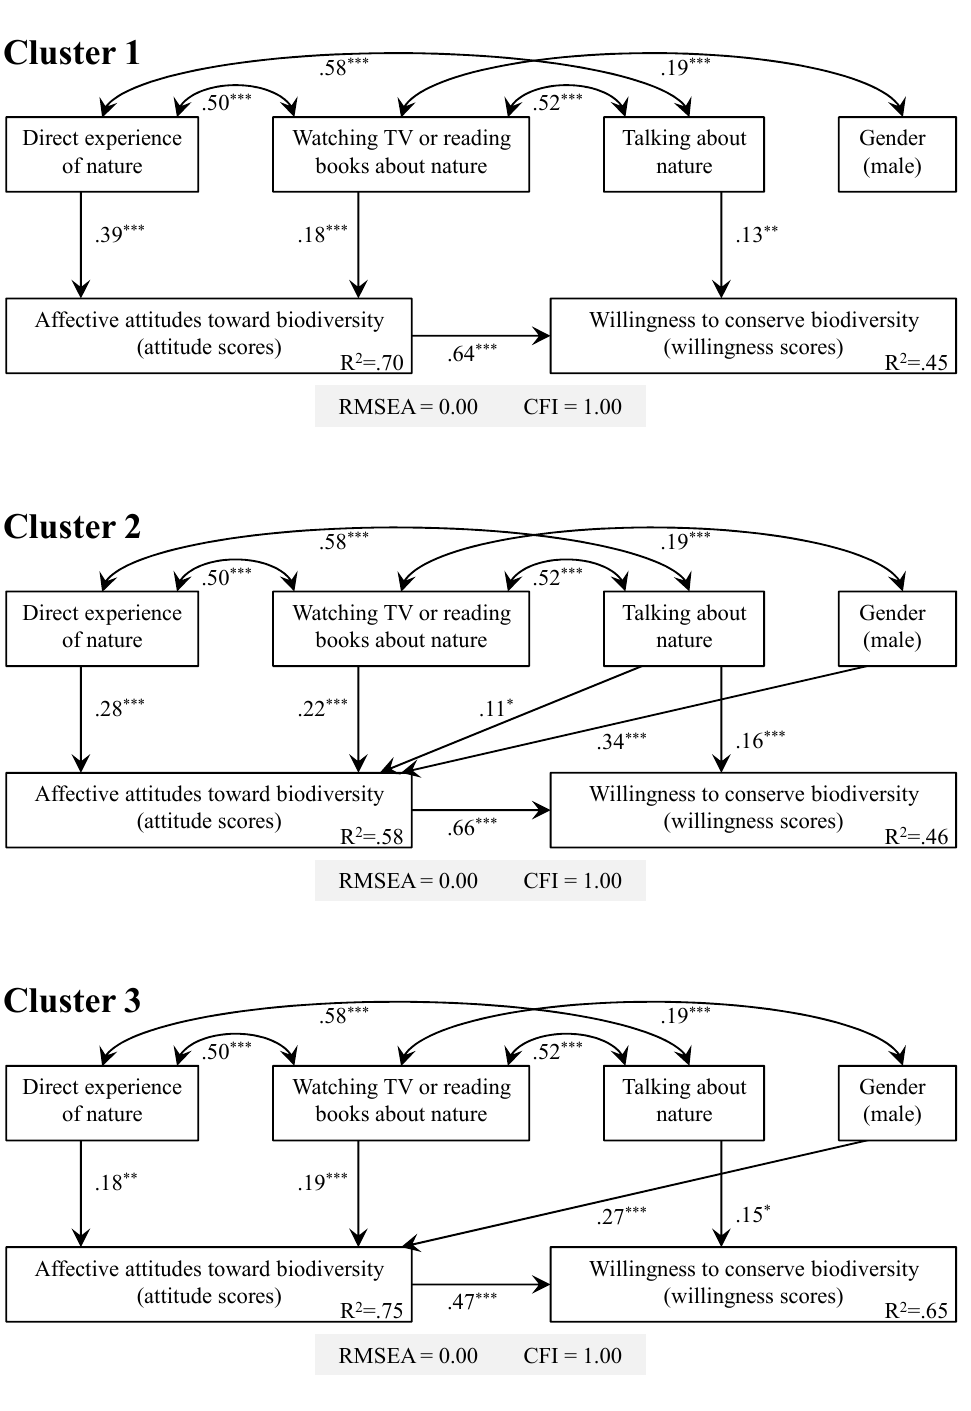
Figure 5. Models with standardized estimates of parameters (non-significant paths were omitted), predicting children’s attitudes toward (attitude scores) and willingness to conserve biodiversity (willingness scores) for species grouped into Cluster 1, 2, and 3 (see Figure 4). Asterisks indicate the significance levels ( * p < 0.05; ** p < 0.01; *** p < 0.001).